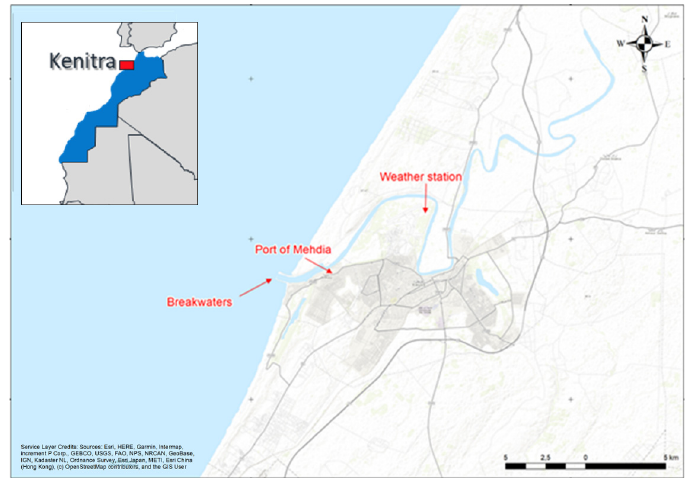
Figure 1. Outlet of the Oued Sebou into the Atlantic Ocean (above: Google Maps Platform) and a general overview of the study region (below).